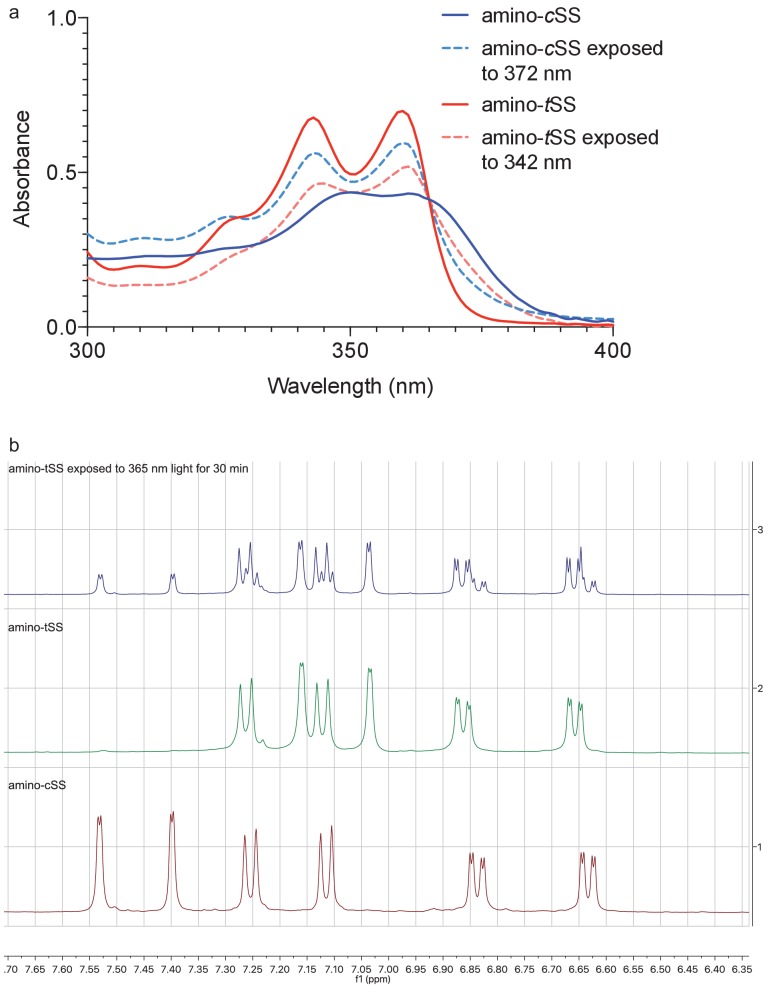
UV absorption and 1H NMR spectroscopy of E/Z isomerization of amino-tSS and amino-cSS.(a) UV-Vis spectra of amino-tSS (red) and amino-tSS after 3 hr exposure to 342 nm (red, dashed), and amino-cSS (blue) and amino-cSS after 1.5 hr exposure to 372 nm (blue, dashed). Photo isomerization was performed in 30 mM DMSO solutions and subsequently diluted 1000 times for UV-Vis spectra measurement. (b) 1H NMR of amino-tSS, amino-cSS, and E/Z isomerization. At the photostationary state (amino-tSS exposed to 365 nm) the ratio of amino-tSS to amino-cSS is approximately 2:1 as determined by NMR.Figure 1—figure supplement 2—source data 1.UV spectra of amino-tSS and amino-cSS.